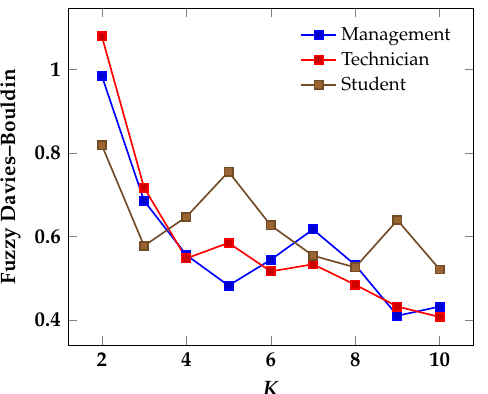
Figure 5. Local-only Davies–Bouldin index for different (but not all) clients. According to the index and the elbow method, each client has a different number clusters locally (management, K = 5; technician, K = 4; student, K = 3).